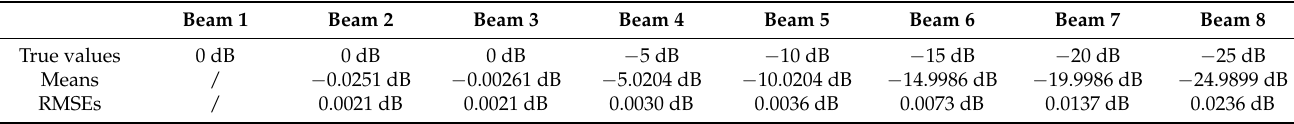
Table 2. Relative amplitude statistical results.